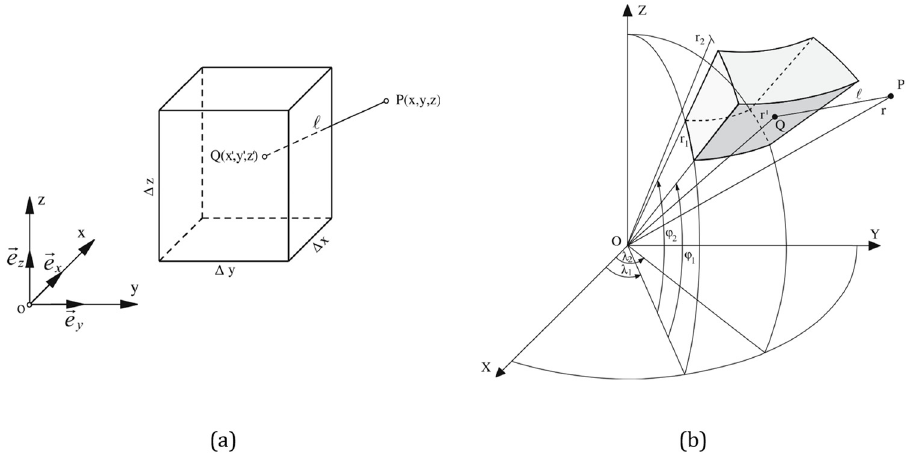
Figure 1: ( a ) Geometry of fl at - topped rectangular prisms and ( b ) geometry of tesseroid. Source: Heck and Seitz ( 2007 )